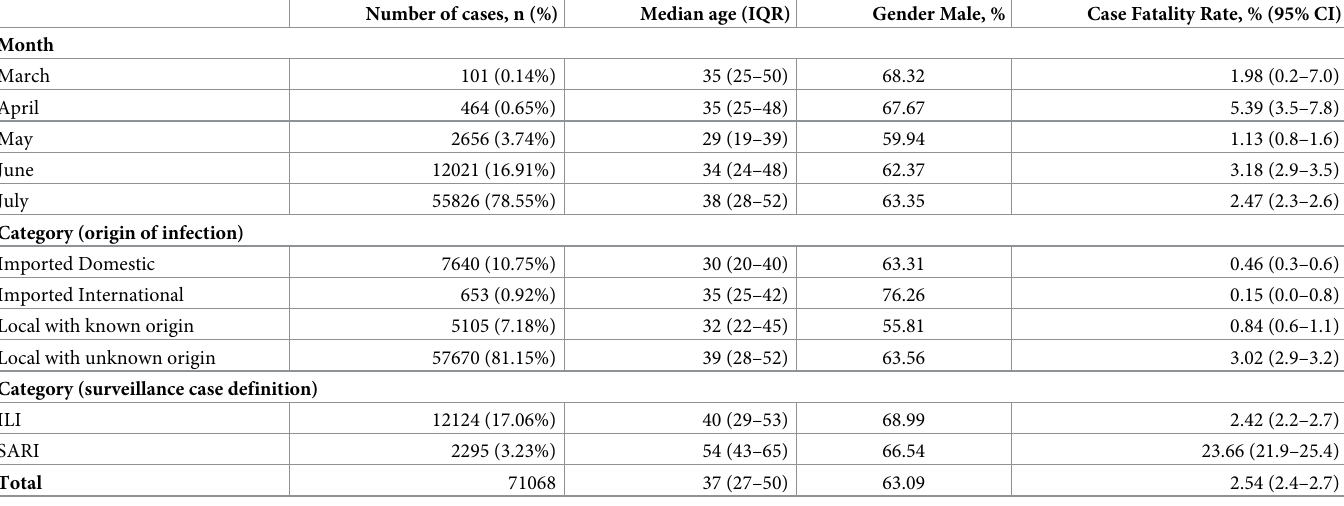
Table 1. Distribution of 71068 COVID-19 cases across time and categories and their demographic characteristics and case fatality rate (Karnataka, India; up to 21 July 2020). Number of cases, n